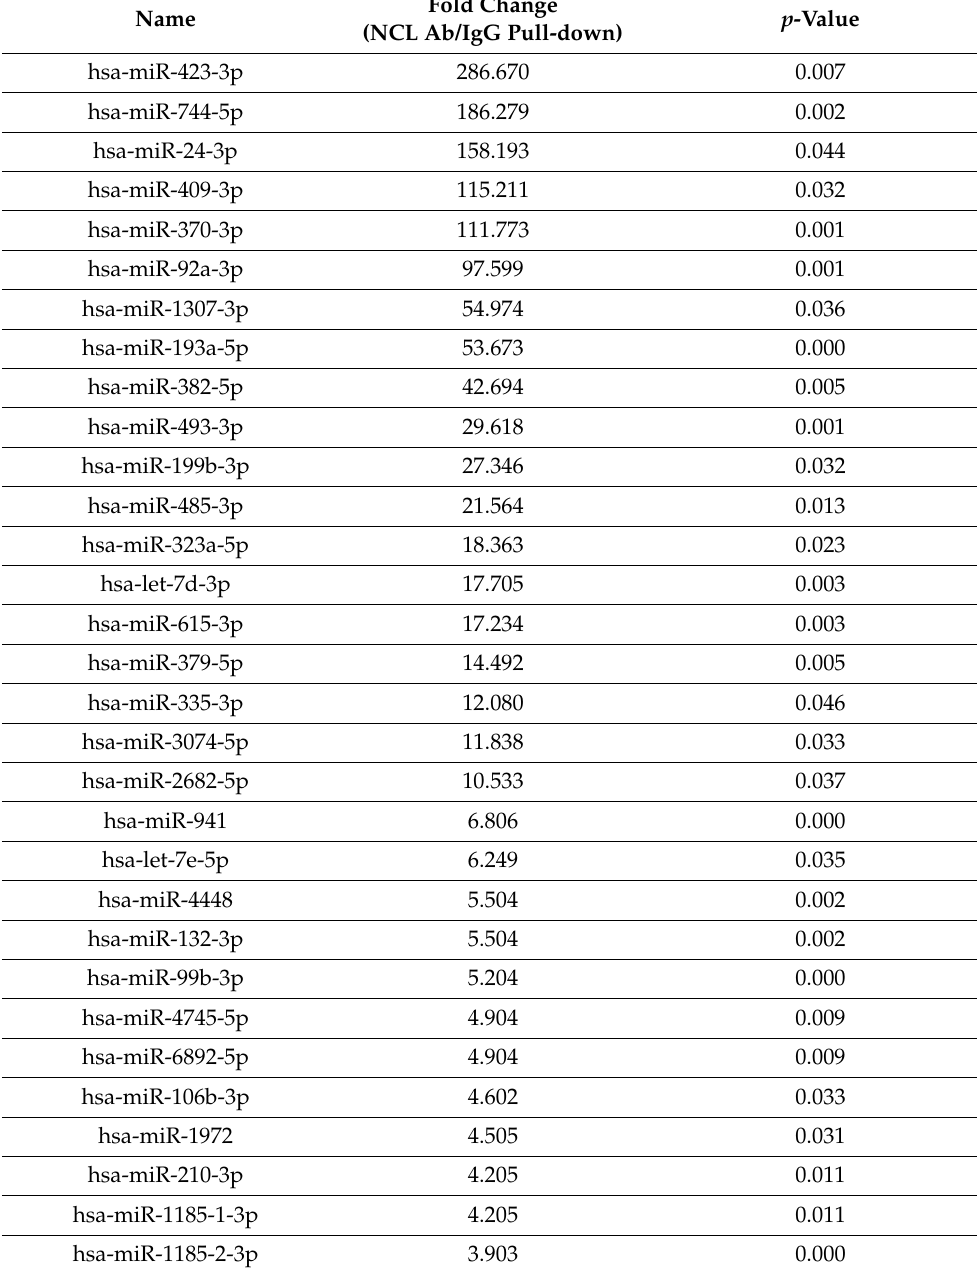
Table 1. miRNAs bound to NCL in PASMCs. RNAs from PASMCs were immunoprecipitated with an NCL antibody or IgG, followed by NGS-based small RNA sequencing